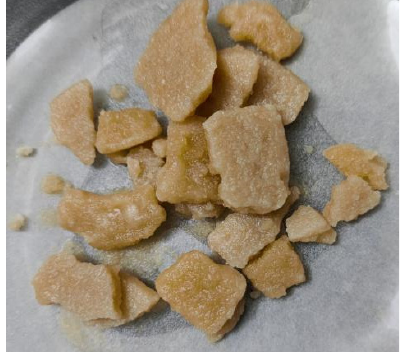
Figure 6. Morphology of the solid compound.